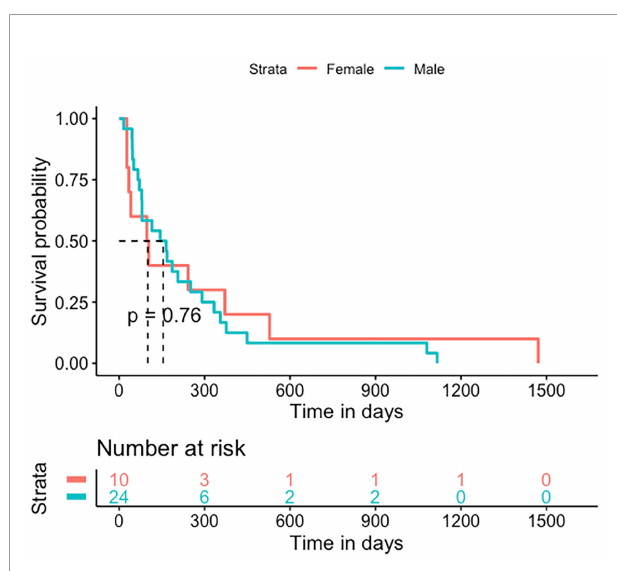
FIGURE 3 | KPS before, immediately before shunting, and after shunting is represented by a Line plot showing individual KPS. Progression in the KPS is colored in green, a decline in red and stability in blue. Median KPS before and after surgery is 50 with no statistical difference.